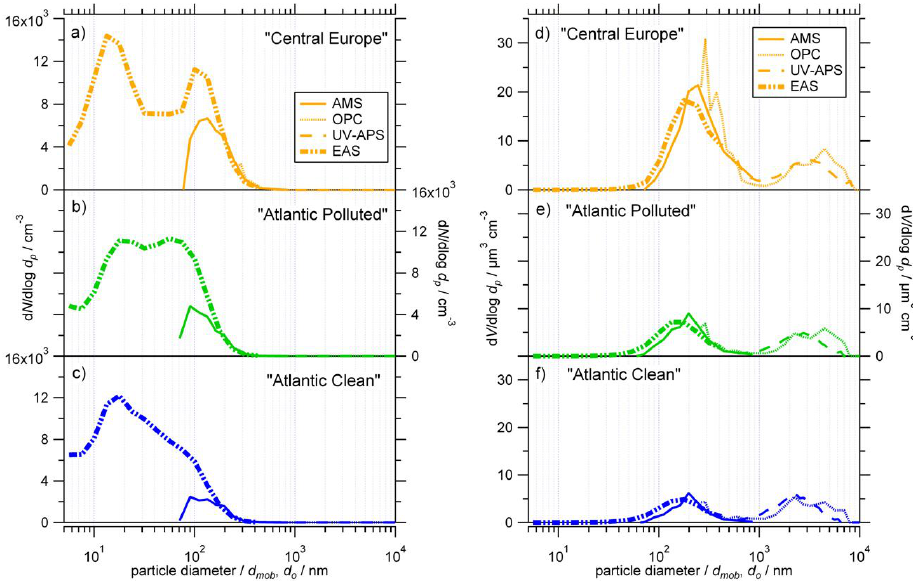
Fig. 9. Size distributions (median) for the different air masses, measured at Sub NE with AMS, EAS, OPC, and UV-APS. (a–c) d N /dlog d p , (d–f) d V /dlog d p . AMS total mass is converted to d V /dlog d p , and AMS d va to d mob assuming a size-dependent density (derived from the chemical composition measured with the AMS). UV-APS d ca is converted to d mob assuming an average density of 1.65gcm − 3 (from the average chemical composition from AMS and BC measurements). d V /dlog d p of EAS, OPC, and UV-APS is calculated from the measured d N /dlog d p , and vice versa for the AMS.